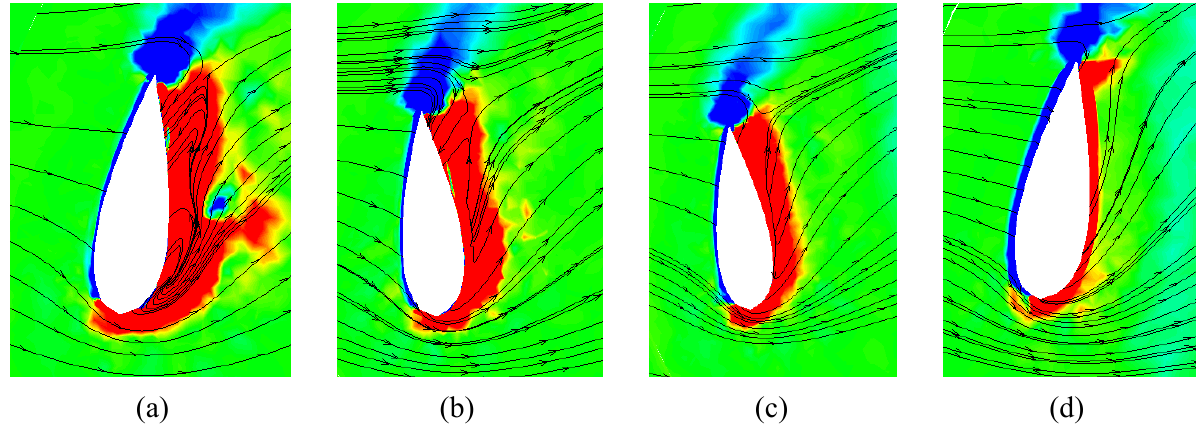
Figure 15. Zoom on Blade 1 at ( a ) TSR = 1.41, ( b ) TSR = 2.00, ( c ) = TSR = 2.40 and ( d ) TSR = 3.51.